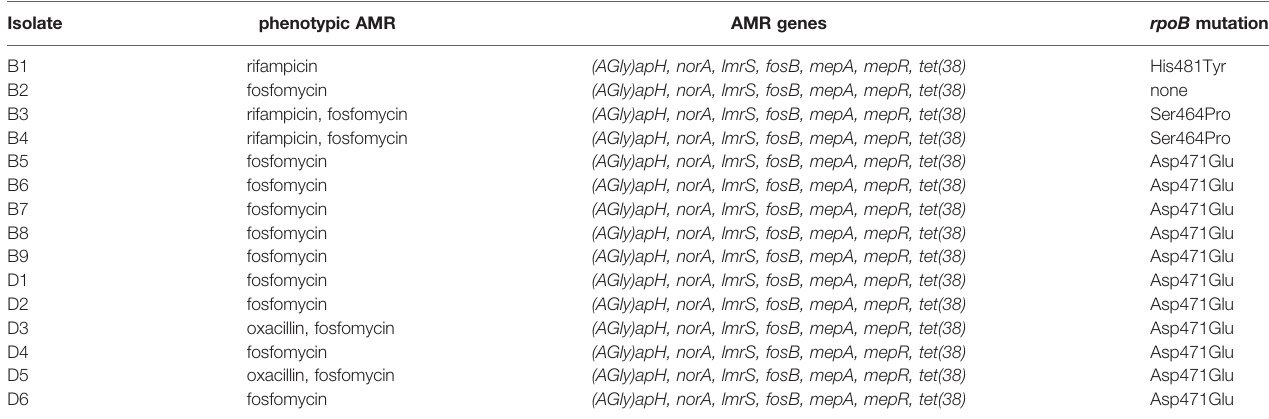
TABLE 1 | Phenotypic antimicrobial resistance and detected resistance